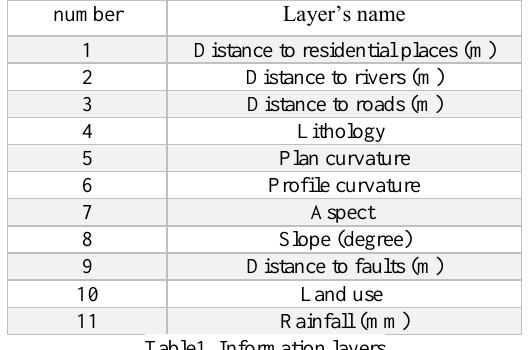
Table1. Information layers